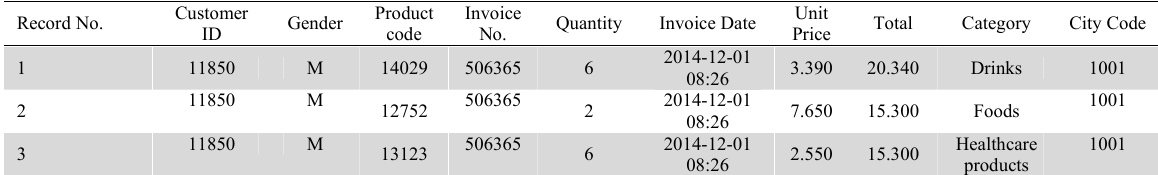
The integrated data set of the company Record